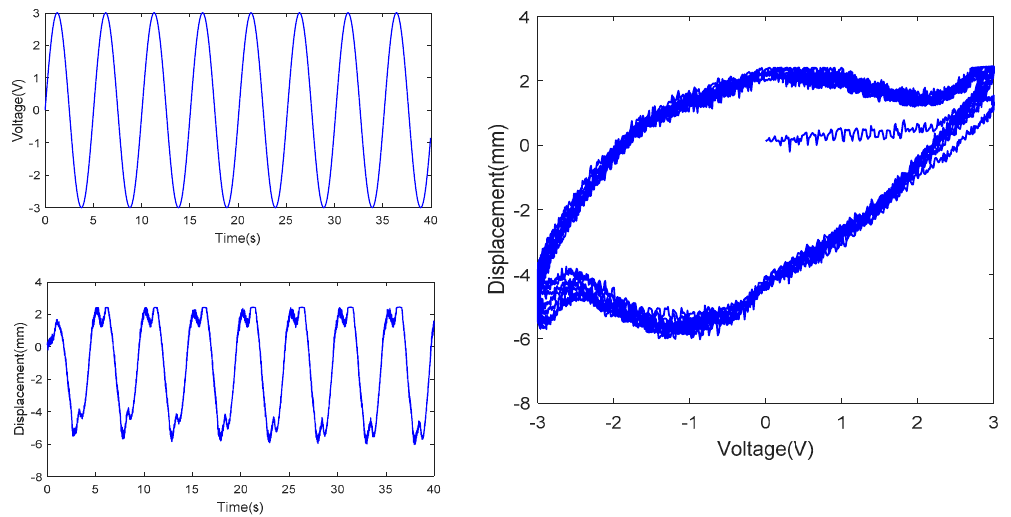
Figure 10. Tip displacement at actuating voltage with amplitude of 3V and frequency of 0.5/2 π Hz.